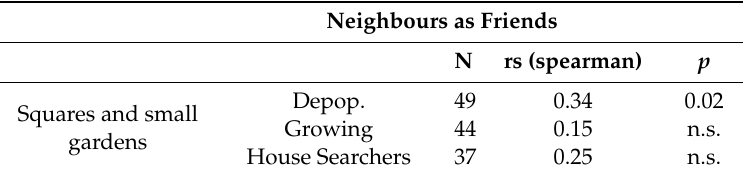
Table 1. Significance and correlation coe ffi cients rs between the levels “squares and small gardens” and “neighbours as friends”, according to the subgroups: “depopulating neighbourhoods”, “growing neighbourhoods”, and “house searchers”.